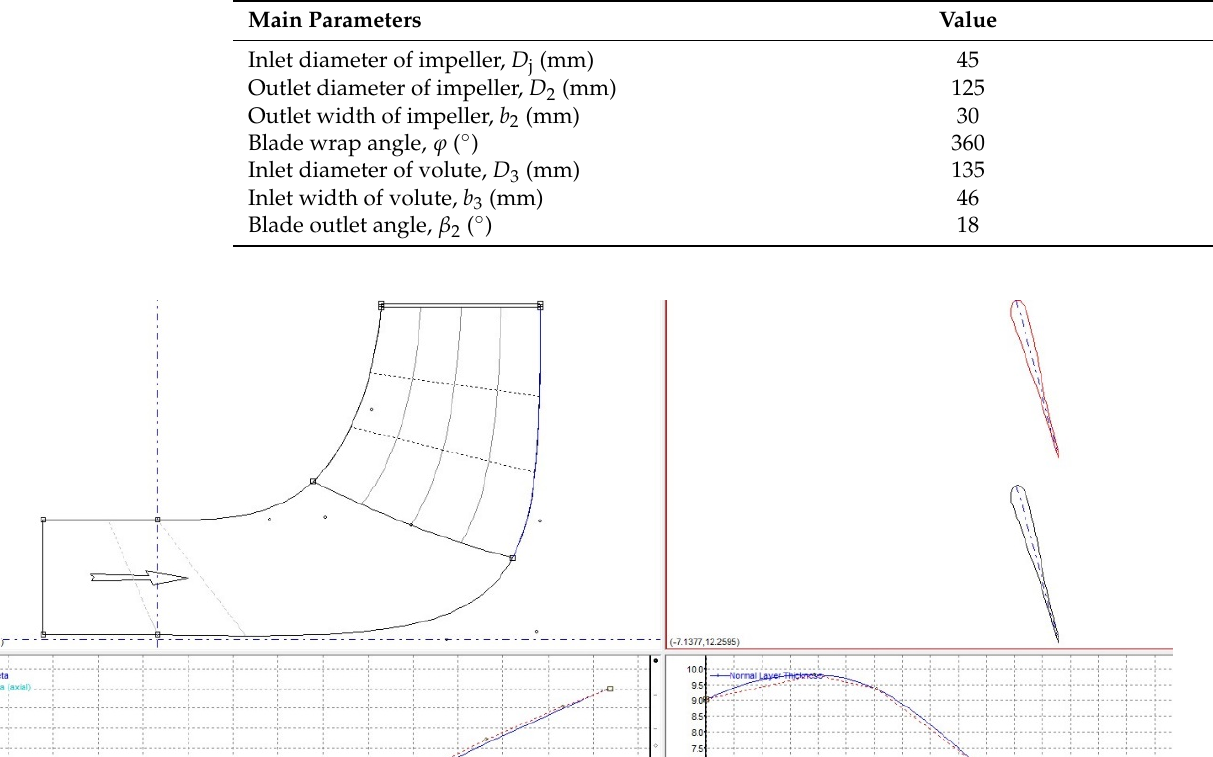
Table 1. Main geometric parameters of the pump.